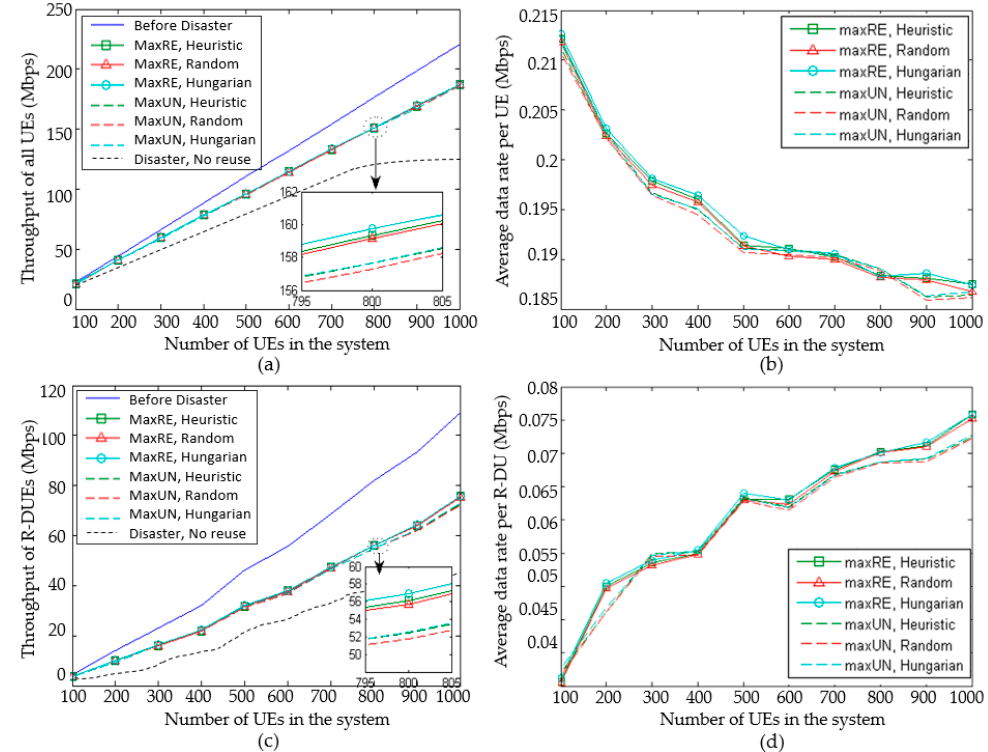
Figure 8. The impact of resource allocation methods: ( a ) throughput of all users; ( b ) average data rate per UE; ( c ) throughput of R-DUs; ( d ) average data rate per R-DU.